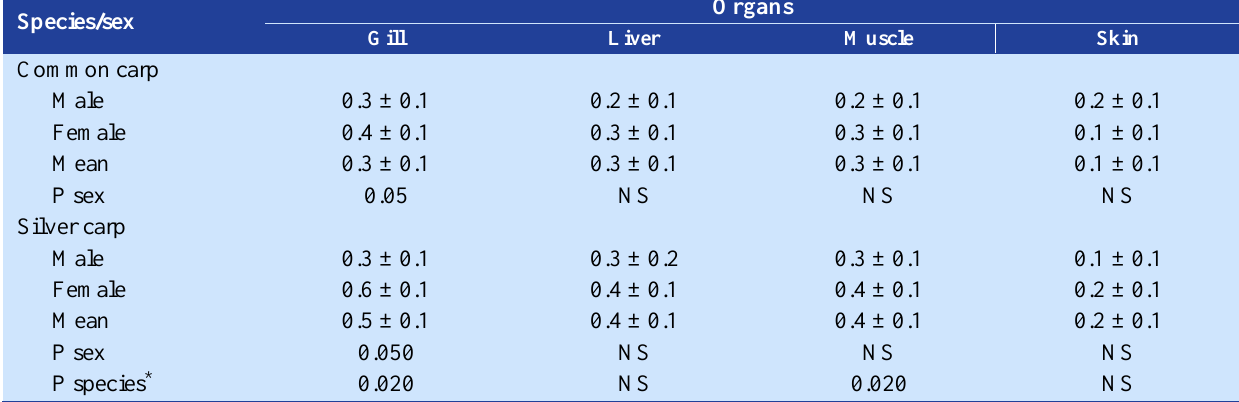
Table 1. Mercury concentrations (mean ± standard deviation) in the organs of common carp and silver carp